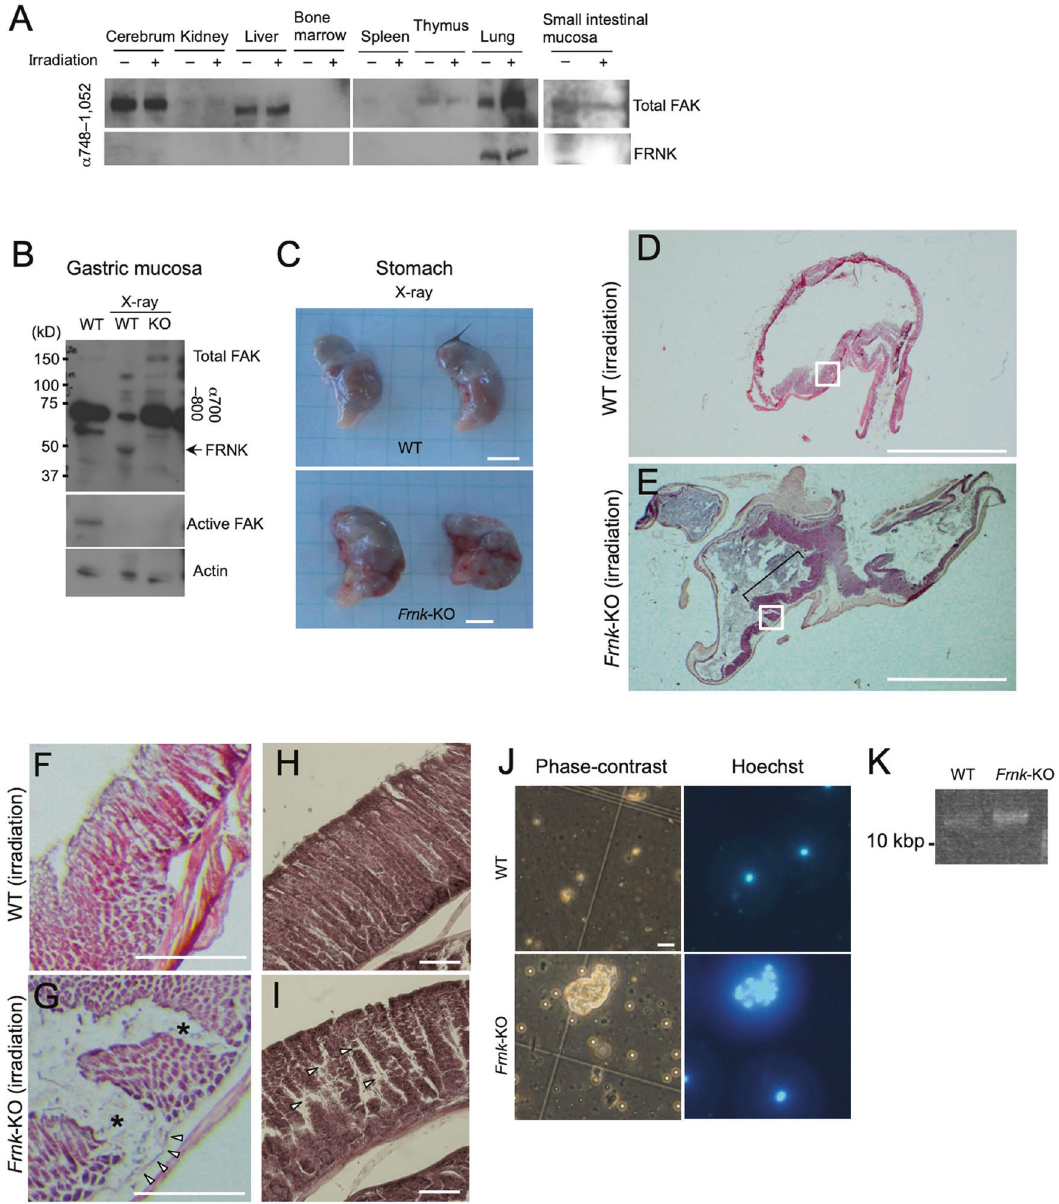
Fig. 6 FAK/FRNK replacement protects gastric tissues from genotoxic stress. A WT mice were or were not irradiated with 5 Gy, and analysed for the expression of FAK and FRNK in each tissue after 24 h. B WT and Frnk -KO mice were irradiated with 5 Gy, and analysed for the expression of FAK and FRNK in the gastric mucosa after 24 h. Among the various tissues, the gastric mucosa was found to express FRNK and downregulate active FAK in response to irradiation ( B ). Note that FRNK was constitutively expressed in the lungs as already reported, but the level was not affected by irradiation ( A ). Actin was used as a loading control. C – K WT and Frnk -KO mice were irradiated with 5 Gy and their gastric mucosa were analysed after 24 h. C Macroscopic images of the stomachs of WT and Frnk -KO mice after irradiation. Scale bar, 5 mm. D – I HE staining of sliced sections of the irradiated stomachs of WT and Frnk -KO mice. F , G are magni fi ed images of the boxed regions in ( D , E ), respectively. In ( E ), the bracket indicates the uneven thickness of the gastric mucosa of Frnk- KO mice. In ( G ), asterisks and white arrowheads indicate partial loss of the epithelial layer and the intact muscularis mucosa, respectively, in the stomachs of Frnk -KO mice. In ( I ), the white arrowheads indicate gaps between aligned epithelial cells in the gastric mucosa of Frnk- KO mice. Scale bars, 5 mm ( D , E ), 0.5 mm ( F , G ), and 100 µm ( H , I ). J Phase-contrast images showing dissociated cells from the mucosal layers after irradiation and their corresponding fl uorescence images showing nuclear staining with Hoechst 33342. K Estimation of the number of dissociated cells from the mucosal layers by visualizing their extracted DNA by EtBr staining after agarose gel electrophoresis. The size of the stained band was more than 10 kbp. the stomach contents, subjected the genomic DNA to agarose gel cells of Frnk -KO mouse stomachs were easily detached from their electrophoresis, and stained the gel with ethidium bromide (EtBr). underlying matrix. When we collected the stomach contents from A stained band was observed only in the samples from the irradiated WT and Frnk -KO mice, we observed more cell masses in stomachs of Frnk -KO mice (Fig. 6K), indicating the presence of a the contents from the stomachs of Frnk -KO mice than from those larger amount of dissociated cells in the stomachs of Frnk -KO mice of WT mice (Fig. 6J). To estimate the quantity of the dissociated than WT mice. cells, we extracted genomic DNA from the detached cells within Cell Death and Disease (2023)